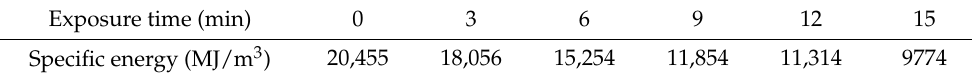
Table 8. The speci fi c energy of rolling force at di ff erent microwave exposure times.